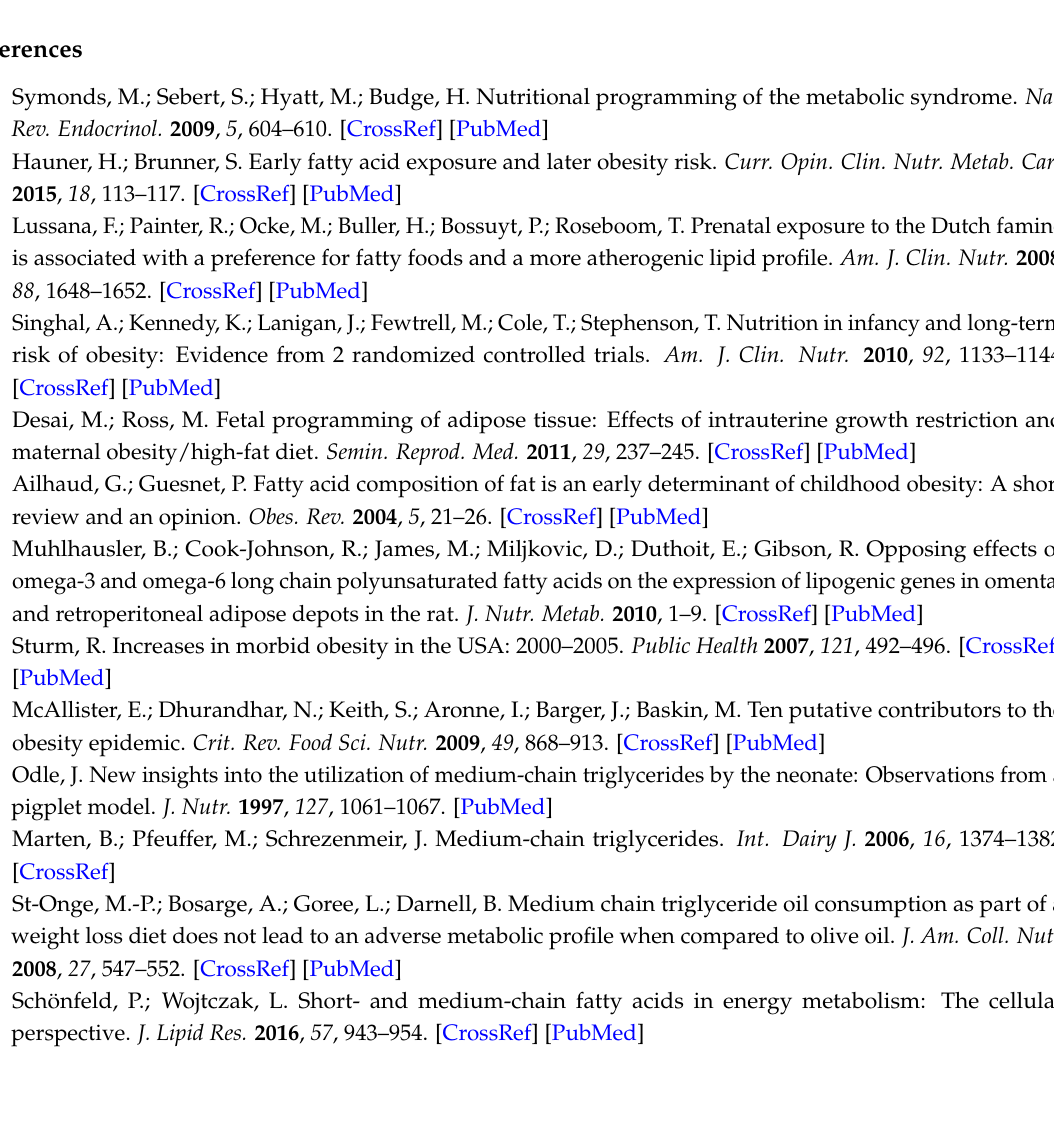
Figure S1: Frequency distribution of ING depot adipocyte cell size in CTRL (n = 4; white bars) and MCT (n = 3; black bars) rats on PN day 98. The table shows mean ING depot weight and cell size. Values are means ± SD; ING, inguinal fat, Table S1: Composition of the experimental diets, Table S2: Mouse milk FA composition at PN day 12 and male pup erythrocyte FA composition at weaning on PN day 21, Table S3: Glucose and insulin dynamics in fasting state and during intravenous glucose and insulin tolerance tests in